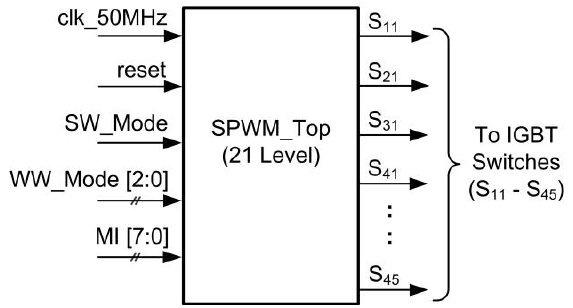
Figure 10. Top level of the SPWM digital switching